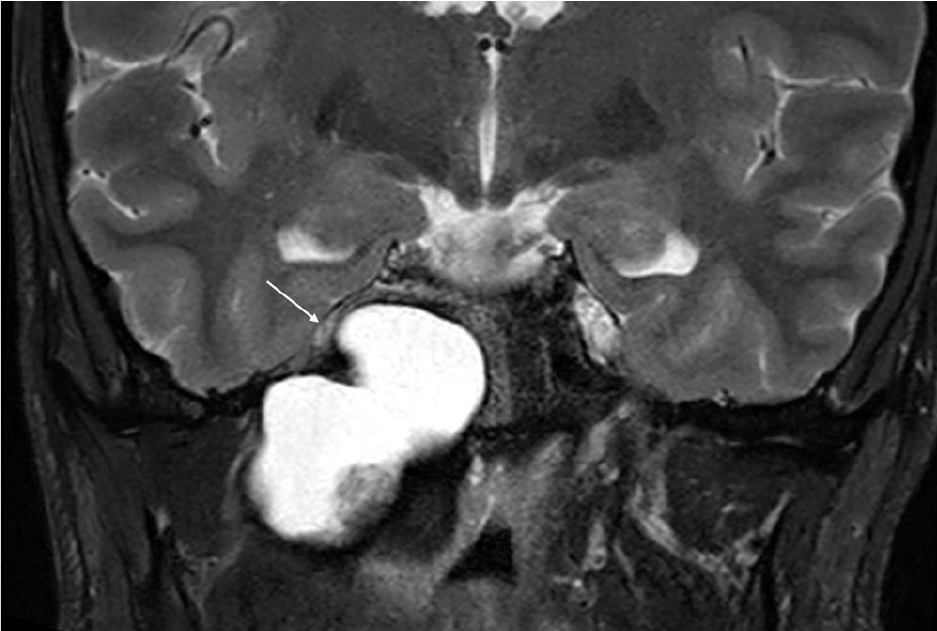
Figure 1. Coronal T2-weighted MRI demonstrating compression of the temporal lobe and Meckel’s cave region (white arrow) by cholesterol granuloma of the petrous apex.